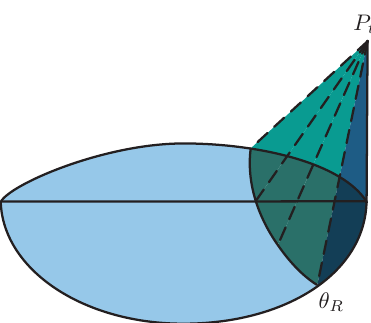
Figure 10. Illustration of the entanglement wedge for a subregion centered around the defect in the right patch of the defect AdS 3 geometry. P t is the point on the boundary at the edge of the causal diamond associated with the relevant boundary region, whose past bulk lightcone will pass through the spatial geodesic connecting (cid:18) L and (cid:18) R